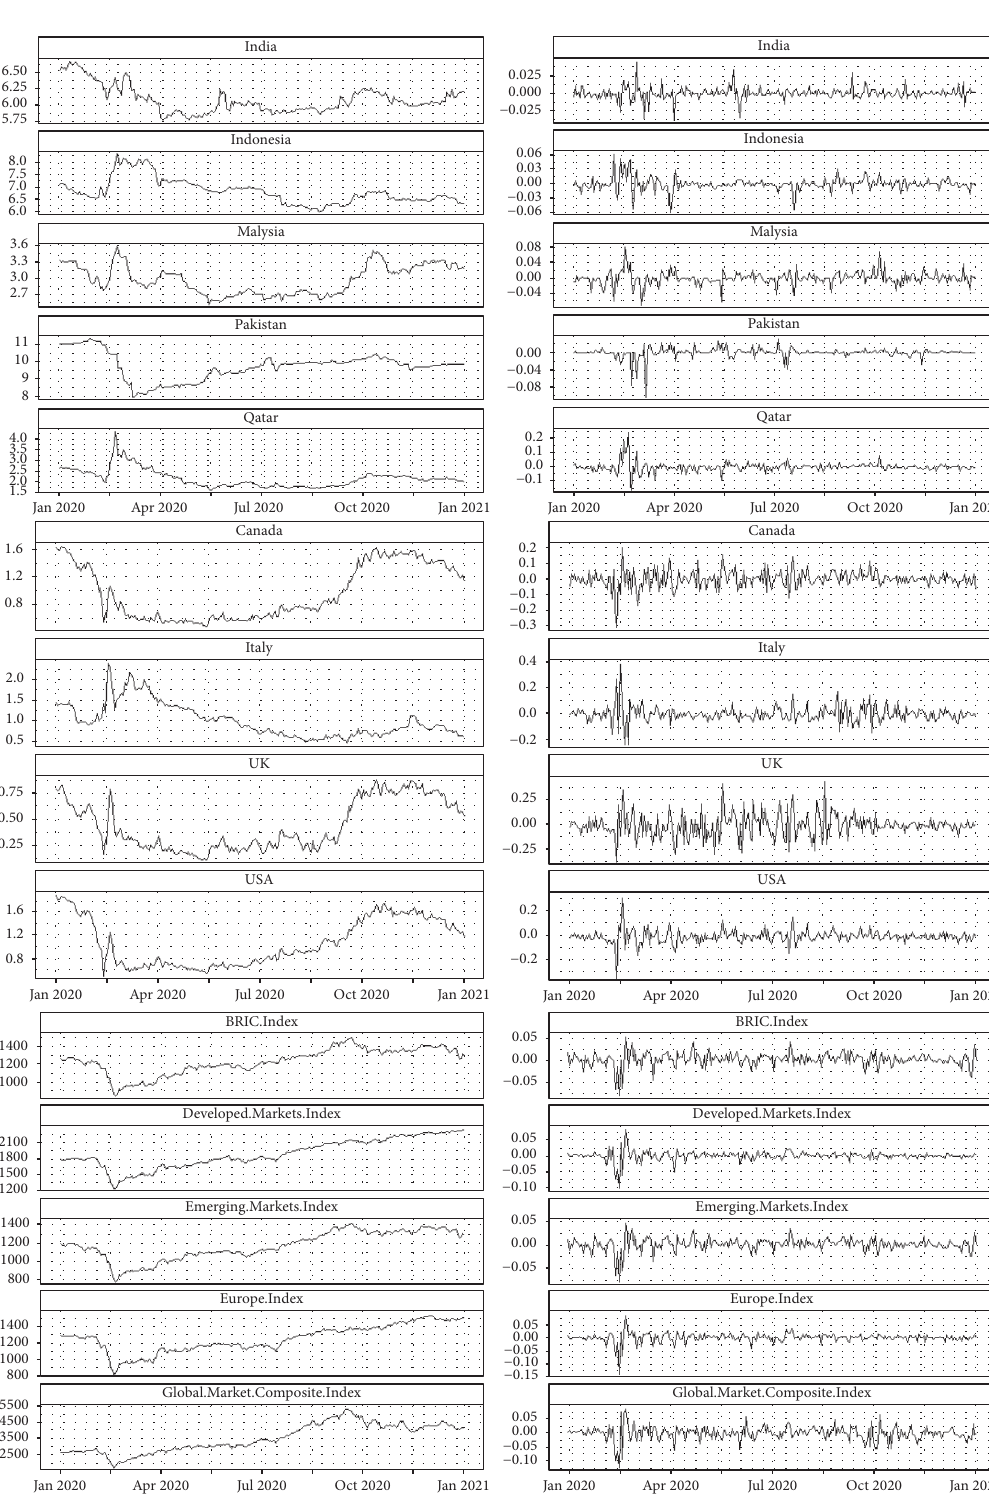
Figure 2: Trajectories of Islamic and conventional bond yield and global stock